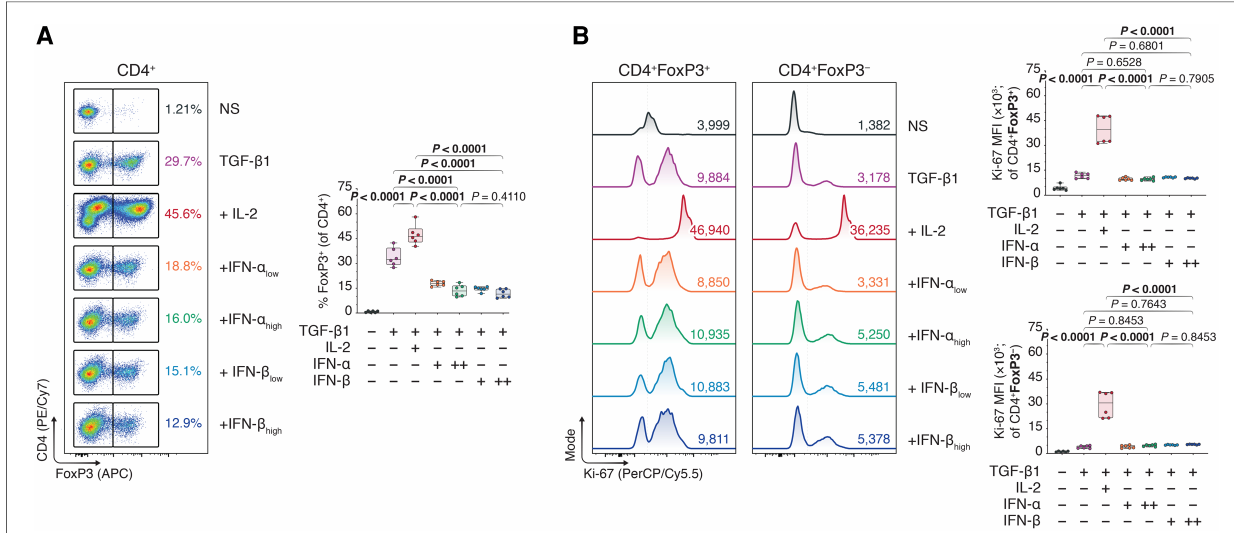
α α α β low (1,000 IU/ml; +IFN- low ), IFN- high (10,000 IU/ml; IFN- high ), IFN- low (1,000 IU/